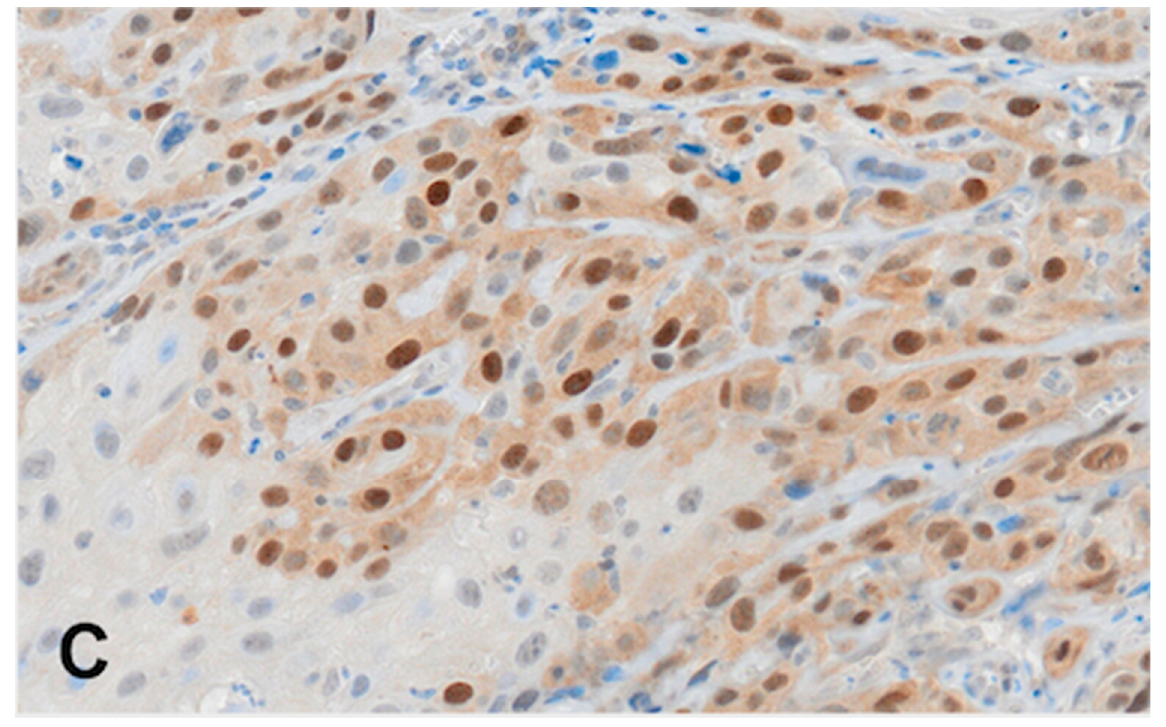
Scheme 1. Representative microphotographs of RAD51 expression in OCOC. ( A ) Weak nuclear expression of RAD51, ( B ) moderate nuclear expression of RAD51, and ( C ) strong nuclear expression of RAD51, IHC, ×200.